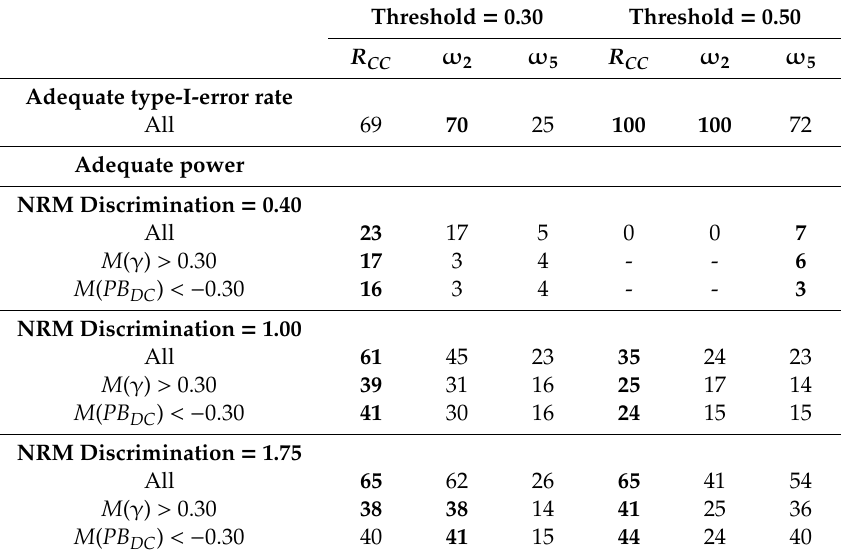
Table 3. Percentages of cells in the simulation design with adequate type-I-error rate and empirical